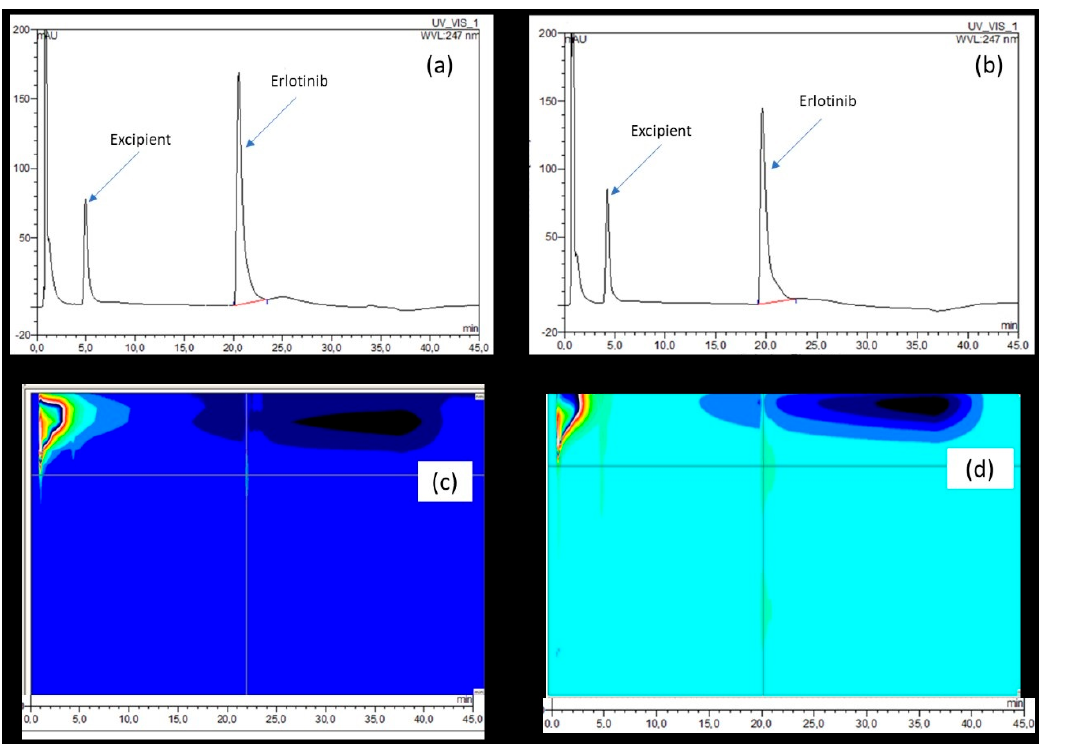
Figure 4. Typical chromatograms recorded at 247 nm on the day ( a ) and 42 days after preparation ( b ) and the corresponding 3D chromatograms ( c , d ) recorded from 200 to 800 nm.